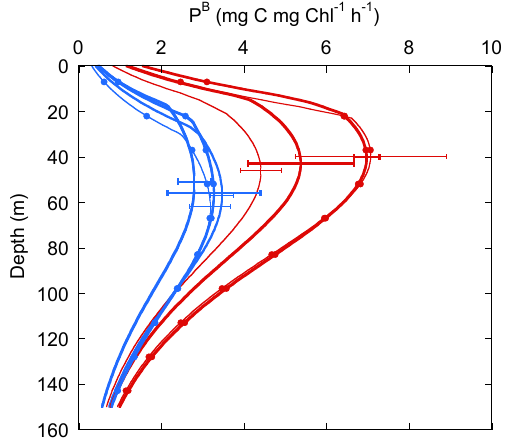
Figure 7. Predicted profiles of biomass-specific productivity ( P B ) for a test set of water column optical conditions (noon, summer solstice, 15 ◦ S latitude, oligotrophic bio-optics, etc.) based on fit- ted BWF E /P-E models estimated from experiments with Syne- max chococcus strains WH8102 (lines with no symbols) and WH7803 (lines with circles) for each of four growth conditions, 20 ◦ C (blue), 26 ◦ C (red), medium PAR (thin line), high PAR (thick line). The line is the average profile ( n =3) for replicate experiments; horizon- tal bars indicate simple standard deviation of P B estimates from replicate experiments at the depth of peak average